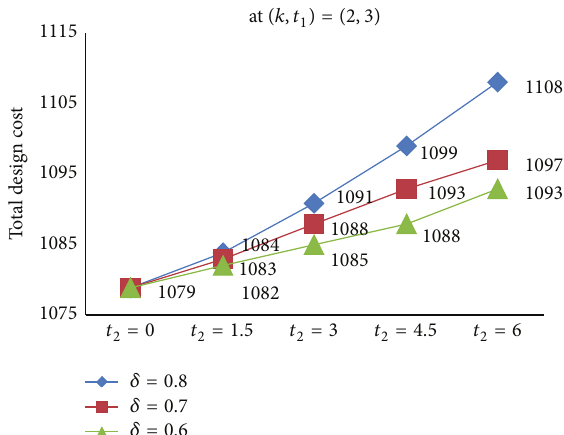
Figure 11: Variation of total design cost with 𝑡 2 for various 𝛿